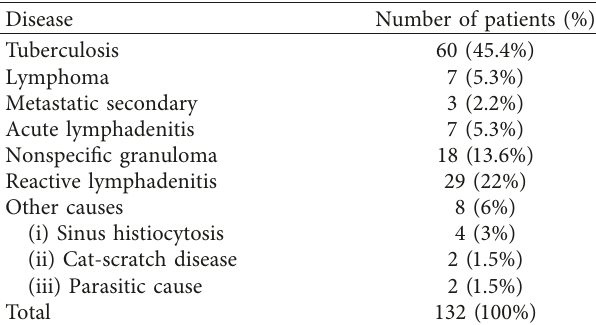
Table 3: Distribution of diseases in biopsied lymph nodes ( n � 132 ) .